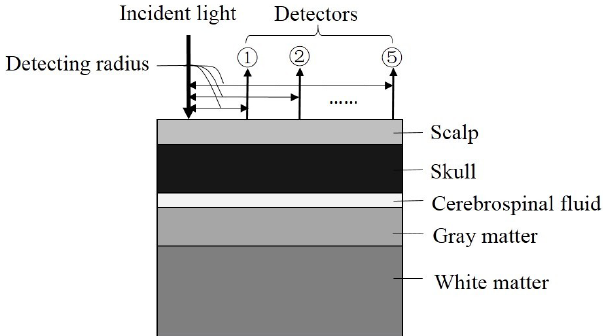
Fig. 2. The simpli¯ed Monte Carlo simulation model of human brain.